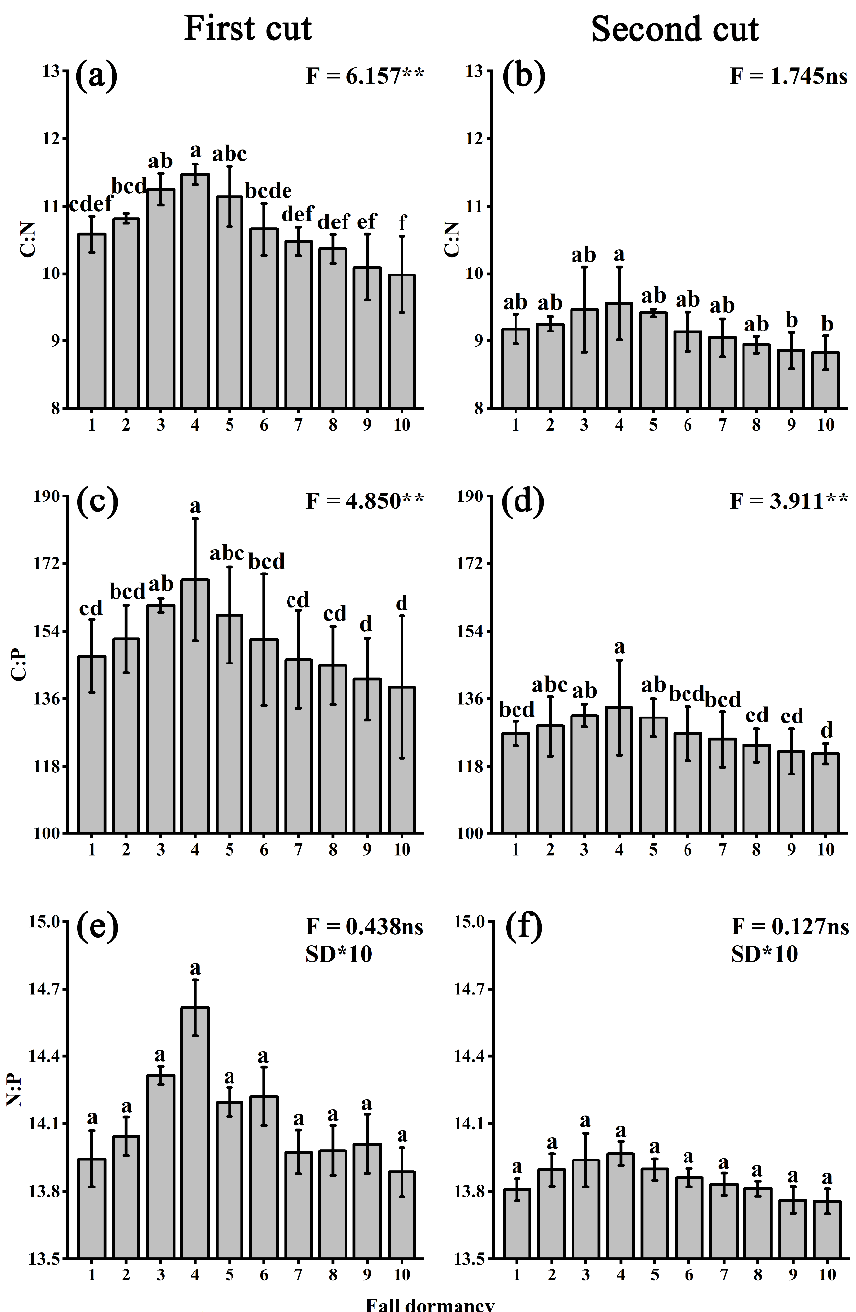
Figure 4. Stoichiometric ratios of elements in mature alfalfa leaves with different fall-dormancy levels in 2021. ( a , c , e ) are the first cut; ( b , d , f ) are the second cut. SD*10 means that the standard error should be multiplied by 10. Different small letters indicate significant differences between diferent fall dormancy levels ( p < 0.05). ns indicates no significant difference between different fall dormancy levels ( p > 0.05), * indicates significant difference between different fall dormancy levels ( p < 0.05) and ** indicates extremely significant difference between different fall dormancy levels ( p < 0.01).